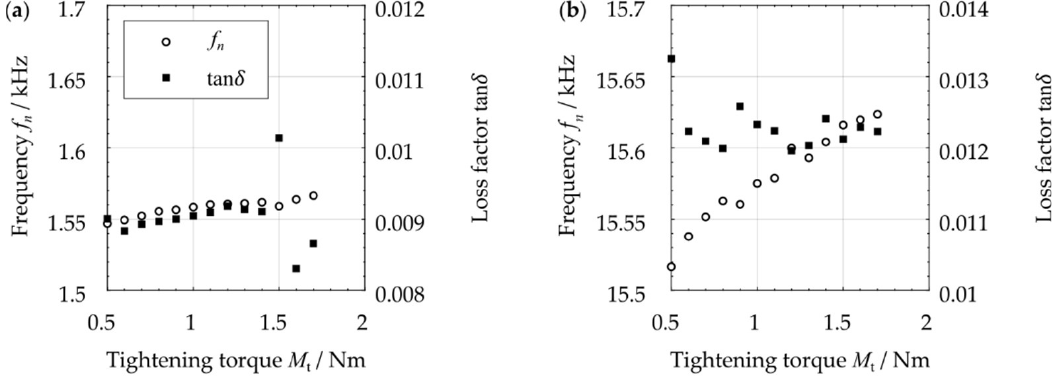
Figure 3. Influence of the tightening torque M t (voltage amplitude of the actuator ˆ U e = 11 V): ( a ) Resonance at 1.5 kHz, ( b ) Resonance at 15 kHz.